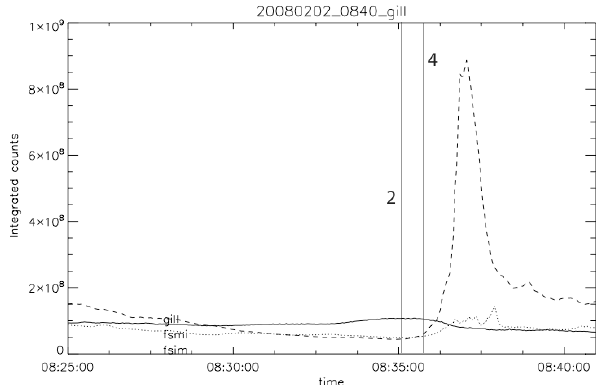
Fig. 16. ∼ 08:35UT event. Strongest signature is at Ft. Simpson. Figure 16 ~08:35 UT event. Strongest signature is at Ft. Simpson. Vertical line labeled Vertical line labeled 2 represents the arc intensification and 4 shows 2 represents the arc intensification and 4 shows the onset of the large scale nonlinear the onset of the large scale nonlinear intensification and accompa- intensification and accompanying substorm poleward expansion (SPE). nying substorm poleward expansion The next event can be discussed in terms of Figure 16. The non-linear intensification and poleward expansion (SPE) associated with this substorm occurred around 8:35:42 UT at Ft Simpson. Figure 17 shows the magnetometer data from the four stations and once again the X component traces at Ft Simpson show remarkable similarity to the timing of total light curve.